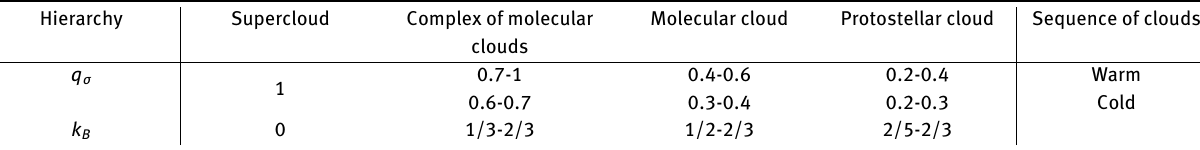
Table 2. The parameters of scale correlations of the interstellar magnetic clouds Hierarchy Supercloud Complex of molecular Molecular cloud Protostellar cloud Sequence of clouds